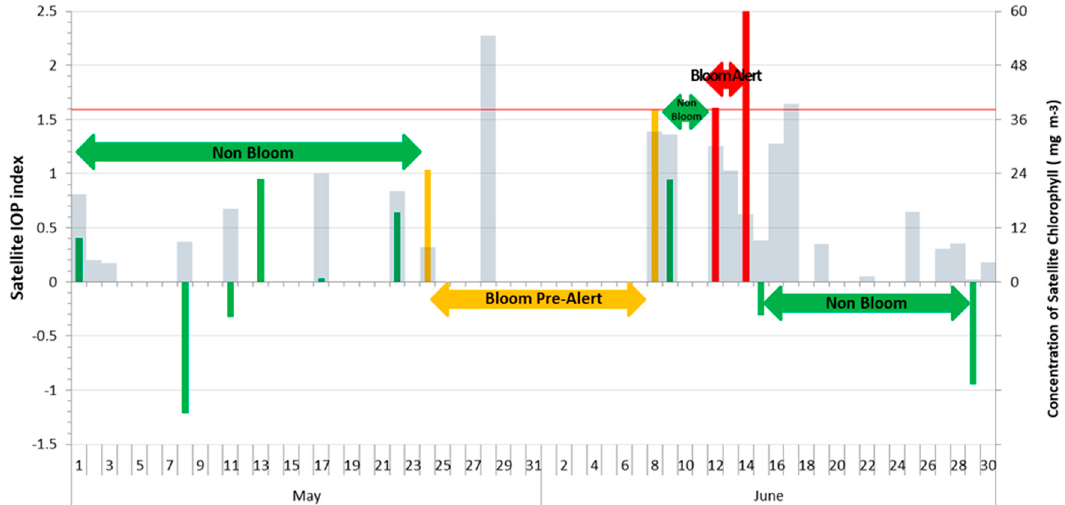
Figure 3. Temporal evolution of the satellite IOP index and satellite chlorophyll a (mg m − 3 ) from 1 May to 30 June 2017 at field point 6. The red line defines the limit of anomalous conditions ( > 1.6 standard deviations of IOP index) and active bloom conditions. Green color bars show IOP index in non-bloom conditions; yellow color bars show IOP index in bloom pre-alert conditions and red color bars show IOP index in active phytoplankton bloom; and gray bars are chlorophyll a . Absence of bars is due to cloud cover.